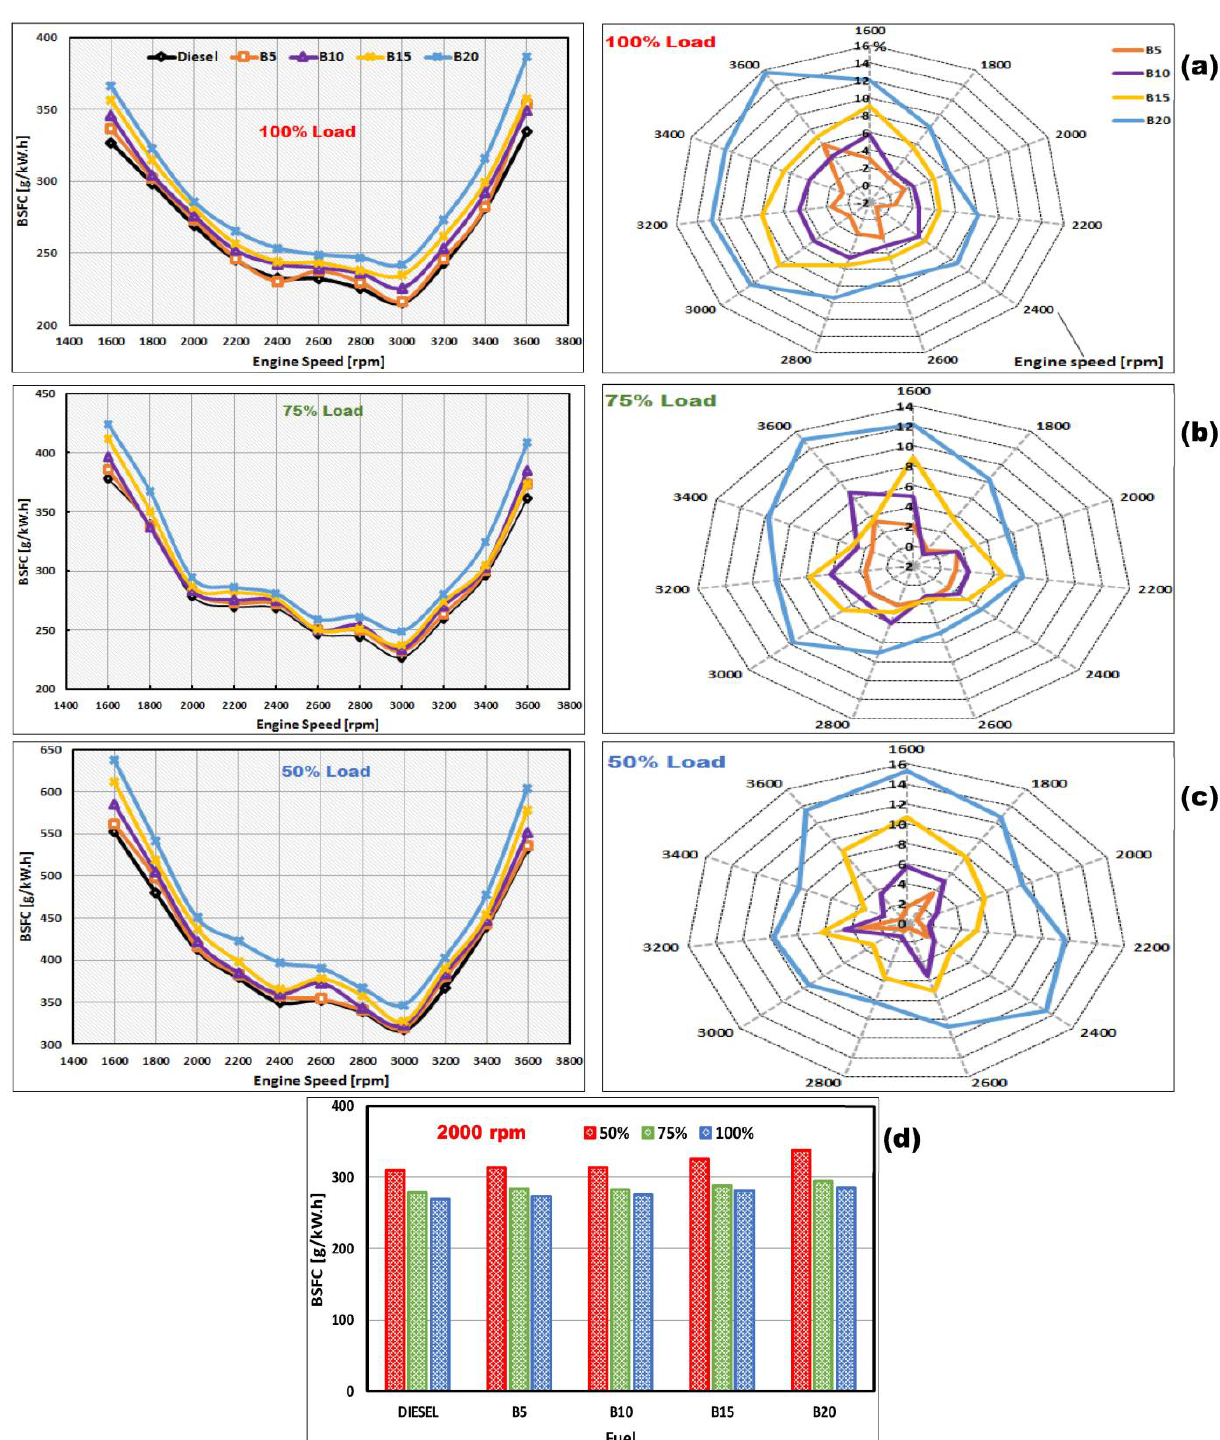
Figure 8. Brake specific fuel consumption variation with engine speed, presented as trends (left) and normalized value contours (right) for (a) 100% load, (b) 75% load, and (c) 50% load; (d) compares all fuels and loads at 2000 rpm.